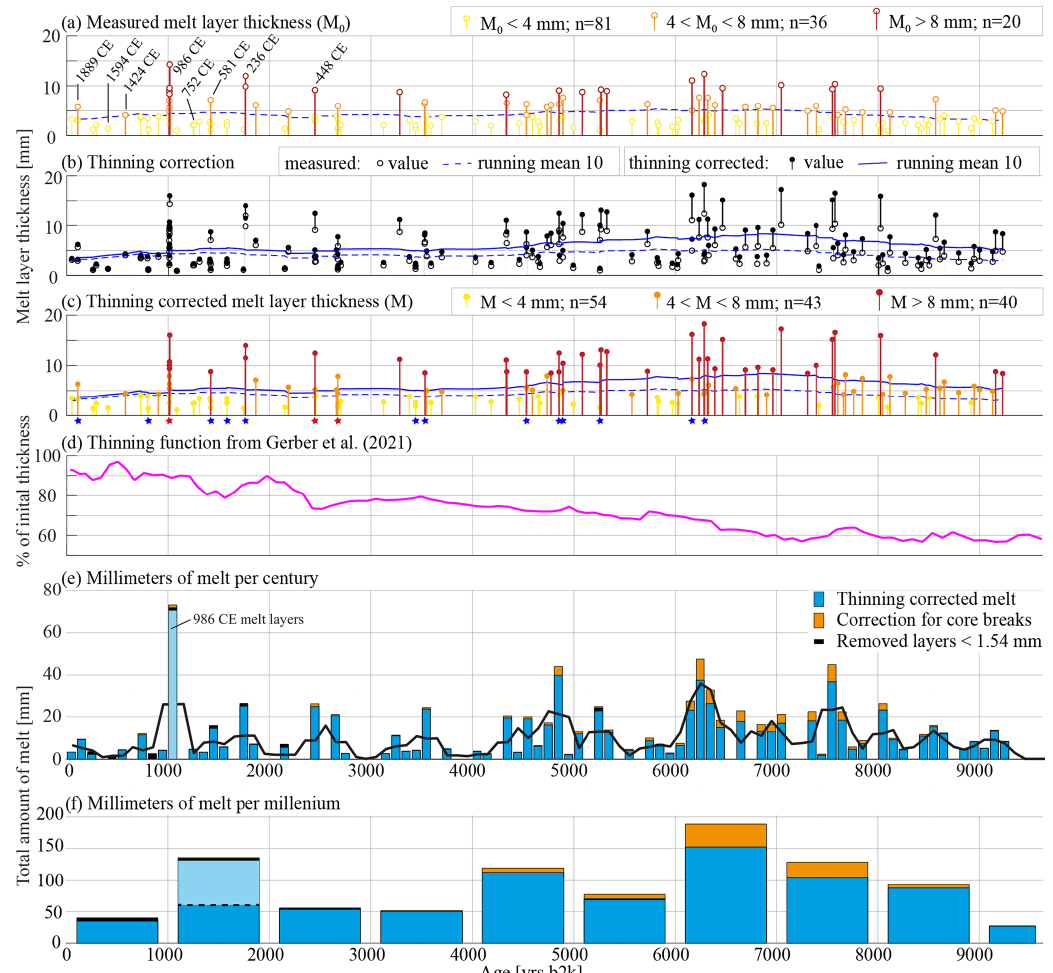
Figure 7. The layer thicknesses of melt layers are shown by the yellow, orange, and red bars (smaller than 4mm, between 4 and 8mm, and greater than 8mm, respectively). To distinguish events occurring within a short period, the layer thicknesses are indicated by circles (measured thicknesses M 0 are indicated by open circles, and thinning-corrected thicknesses M are indicated by closed circles). Running means of 10 events are indicated by dashed (for measured thicknesses) and solid (for thinning-corrected thicknesses) blue lines. Panel (a) shows events that were later compared to tree rings, along with their dates in CE notation. (b) Individual layer thicknesses corrected for thinning using the thinning function from Gerber et al. (2021) shown in (d) . Stars in (c) mark multiple events within 5-year periods (blue stars indicate two events, red stars indicate three or more). Panels (e) and (f) show the millimeters of melt (blue bars, calculated from melt layer thicknesses) per century (e) and millennium (f) , potentially missed events due to core breaks (orange), removed layers smaller than 1.54mm (black, see Fig. A4), and the running mean (black line). Melt layers around the year 986CE are plotted in light